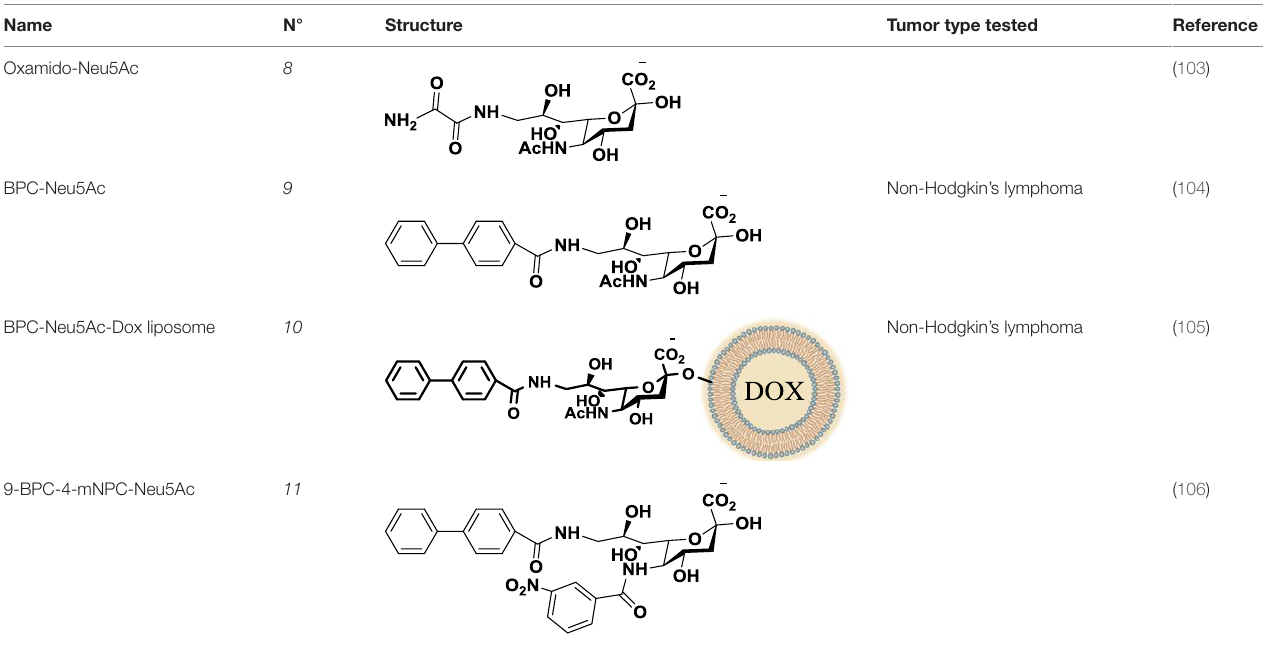
TABLe 2 | Anti-siglec agents described in this review.